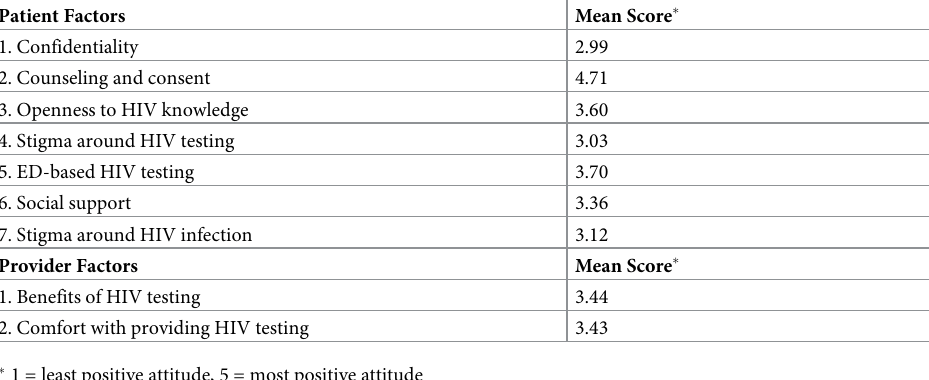
Table 3. Mean patient and provider scores by factor (re-scaled to mean of